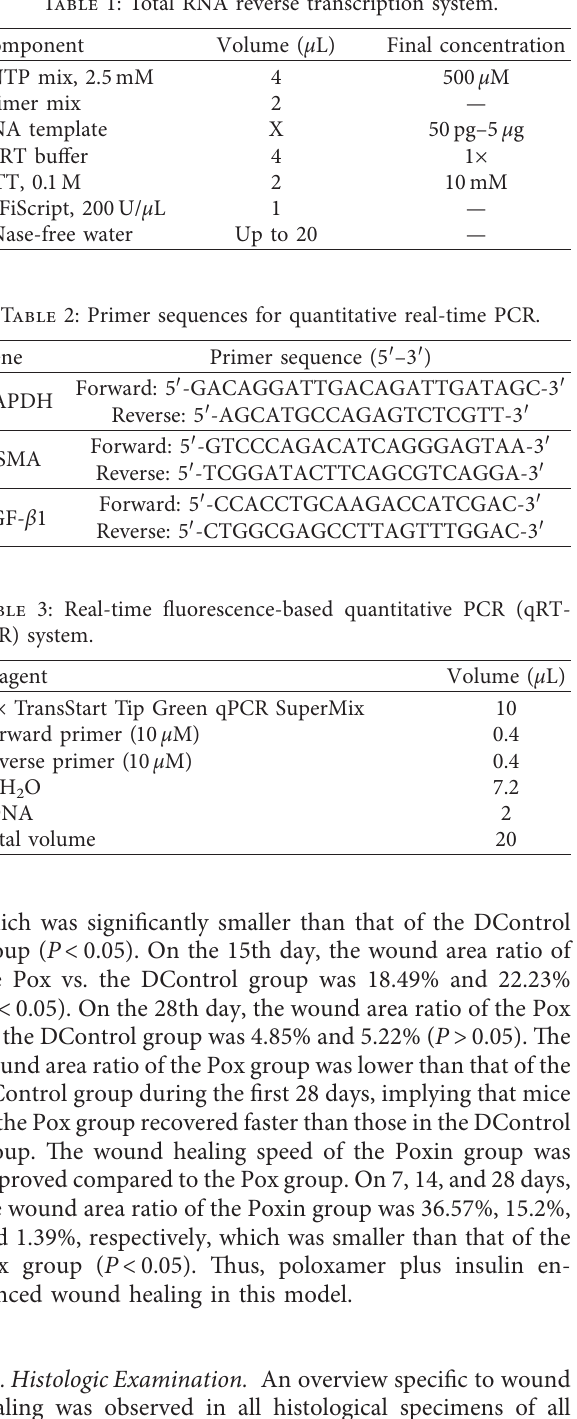
Table 1: Total RNA reverse transcription system.